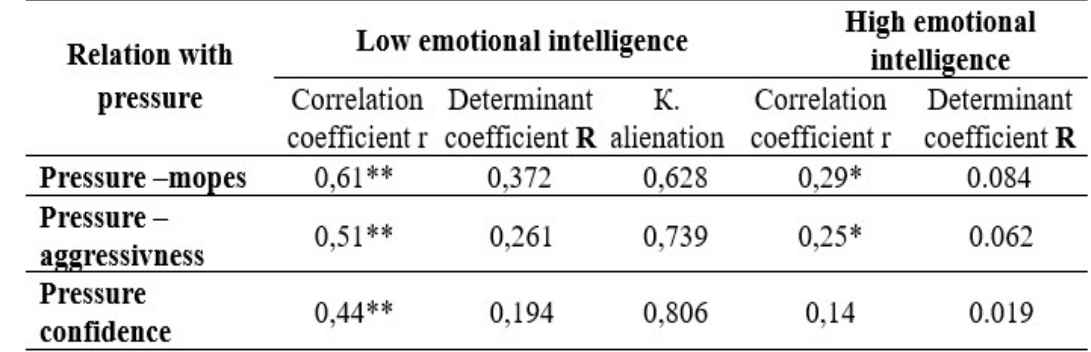
Table 2. Correlations between stress and depravation, aggressiveness and confidence among the participants with low and high emotional